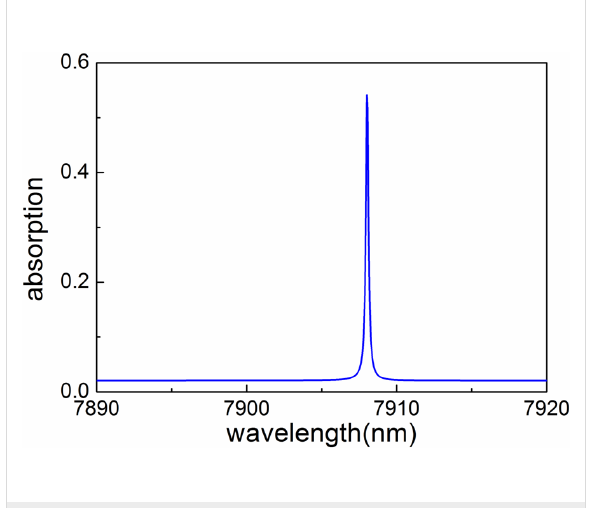
Figure 2: Simulated absorption spectrum for the graphene absorber with operating wavelength at about 7908.03 nm. Here, θ =